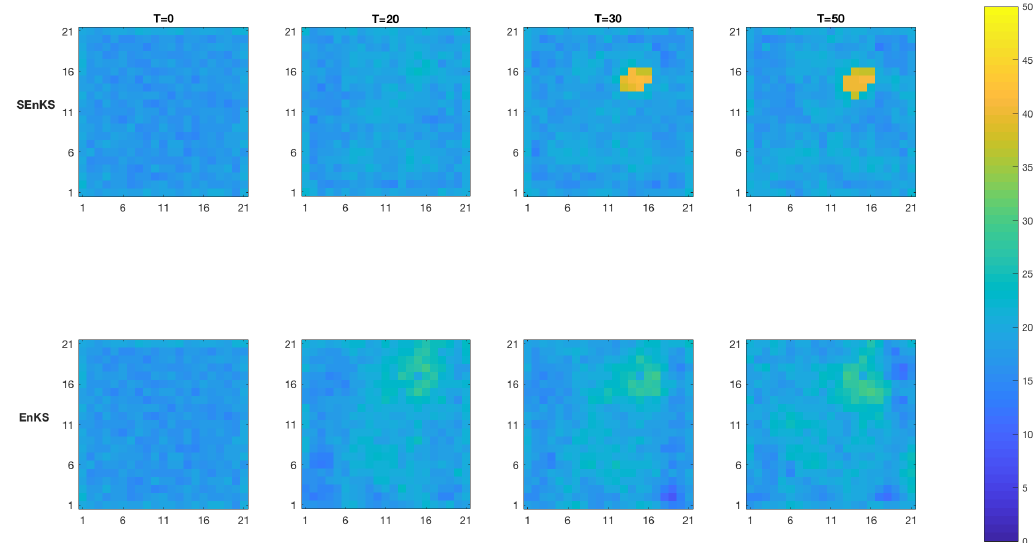
Figure 18. MMAP predictions of the initial temperature ( ◦ C) field at time T = 0,20,30,50 for the SEnKS approach ( upper ) and the EnKS approach ( lower